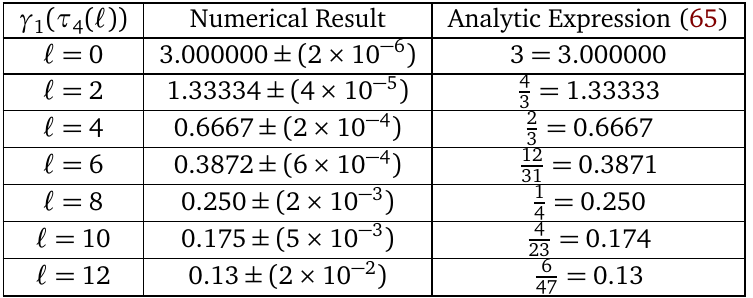
Table 1: Numerical results for the averaged anomalous dimensions of the twist-four ( τ ( (cid:96) )) at order g 1 and comparison with the analytic expression. operators γ 1 4